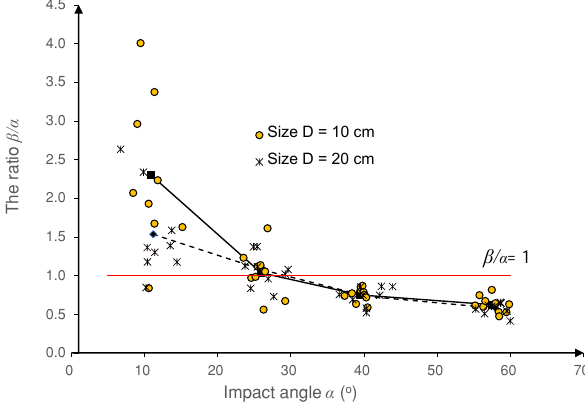
Figure 8. The variation of β/α with the impact angle and the mean value lines for samples with size D = 10cm (solid lines) and D = 20cm (dashed